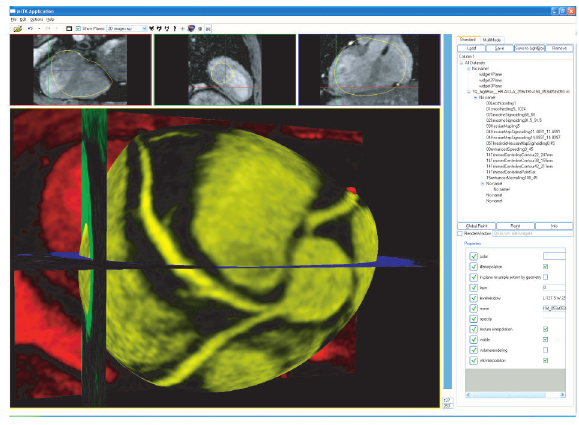
Figure 1: A screenshot of the MRI coronary vessel tracking tool with axial (red), sagittal (green), coronal (blue), and spherically fit- ted “thin plate spline” (yellow) 3D views showing all three main coronaries virtually